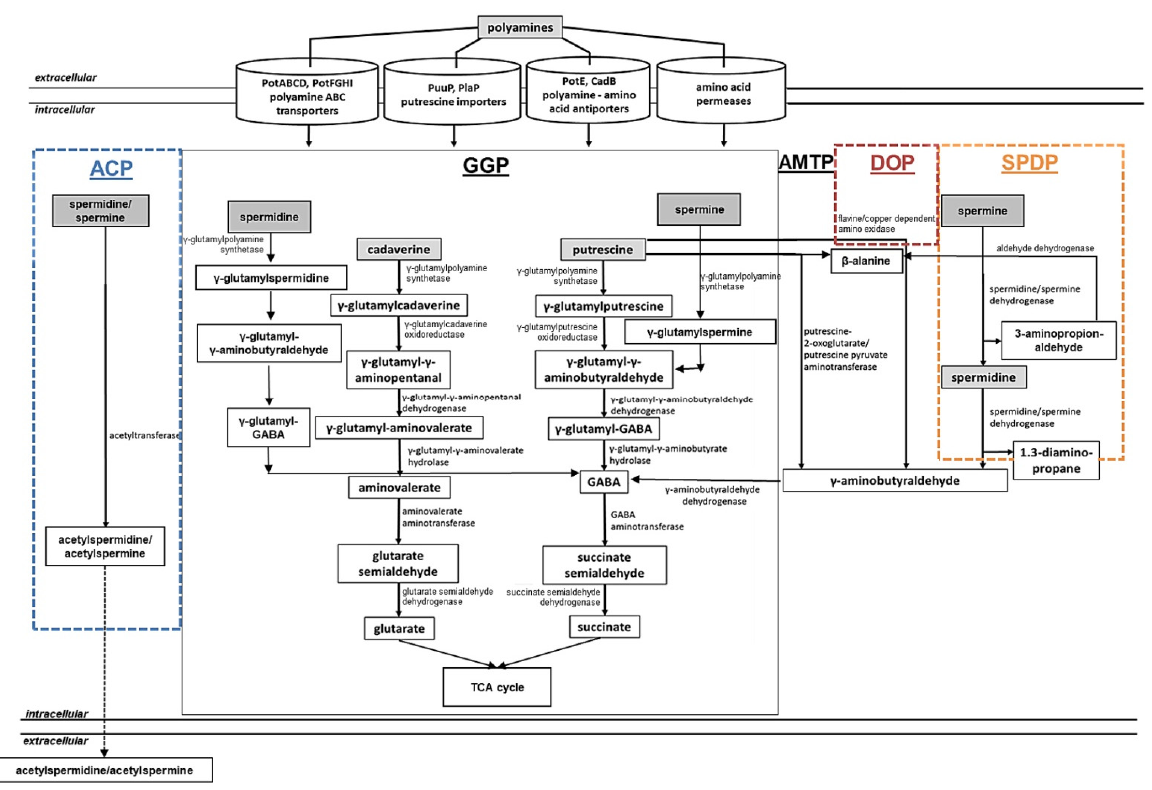
Figure 3. Combined model of bacterial polyamine utilization pathways (adapted from [7,115]). Central reactions and metabolic routes of polyamine catabolic pathways, as well as up-to-date polyamine uptake systems described in bacteria, are shown. ACP, acetylation pathway; GGP, gamma-glutamylation pathways (black box); AMTP, aminotransferase pathway; DOP, direct ox- idation pathway; SPDP, spermine/spermidine dehydrogenase pathway. Dashed arrows